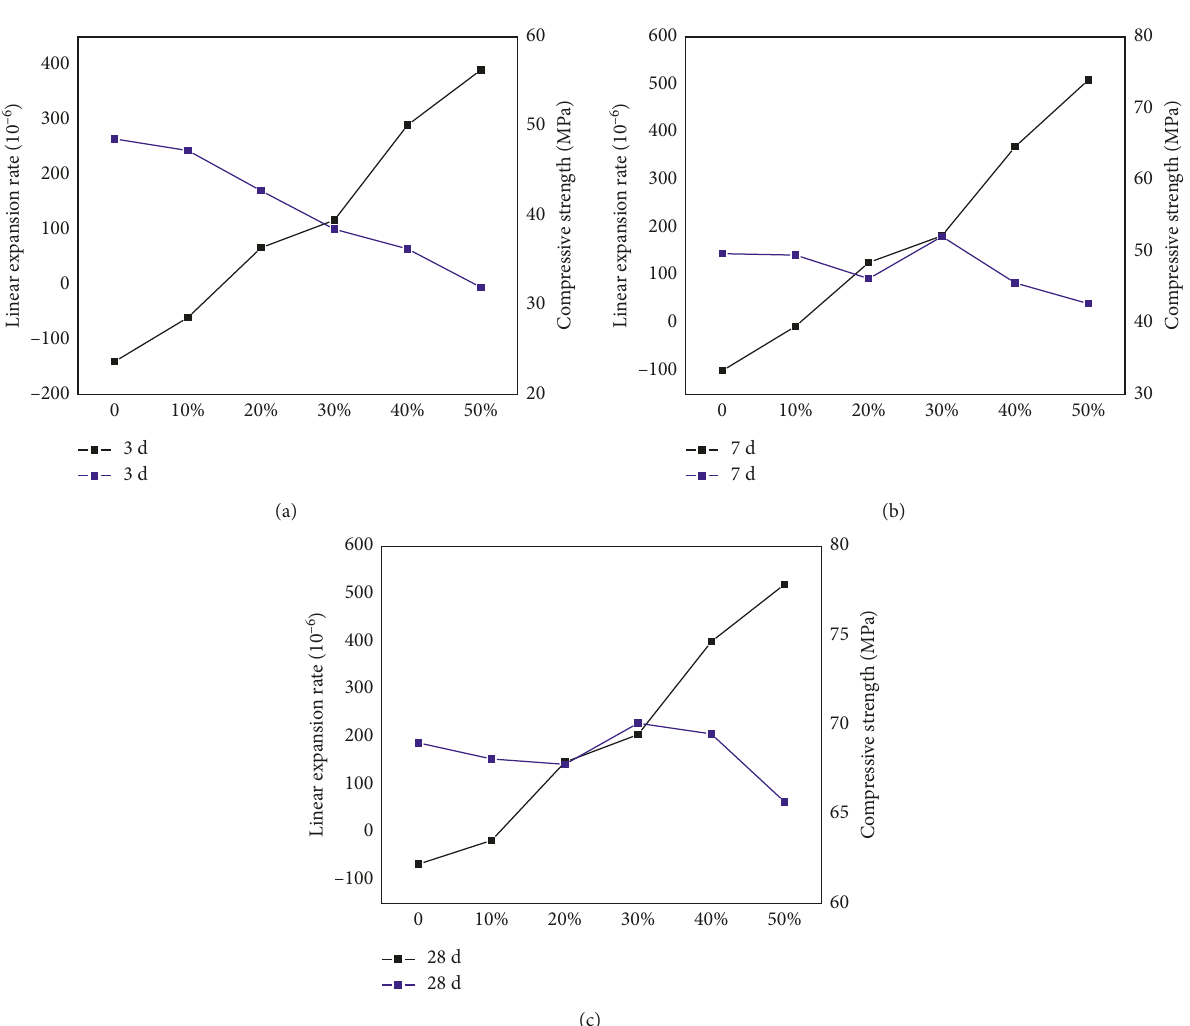
Figure 12: Correlation between the linear expansion rate and compressive